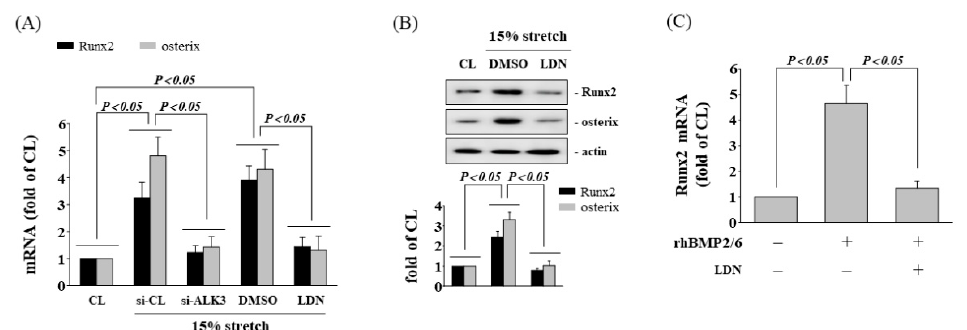
Figure 7. Inhibition of ALK3 receptor decreases HCS-induced osteogenic gene expression. AF cells were maintained in static conditions as CL or subjected to 15% HCS for 8 h. Before being kept as CL or subjected to CS, AF cells were transfected with control siRNA (si-CL), or a specific siRNA of si-SMAD, or were pretreated with DMSO, or specific kinase inhibitors for ALK3 (LDN) for 1 h, and then subjected to 15% HCS for 8 h. The gene ( A ) and protein ( B ) expression of Runx2 were examined by real-time PCR and Western blotting, respectively. The results are shown as mean ± SD. ( C ) AF cells were kept as CL or stimulated with rhBMP-2/6. Before being kept as CL or stimulated with rhBMP-2/6, AF cells were pretreated with DMSO, or specific kinase inhibitors for ALK3 (LDN) for 1 h, and then stimulated with rhBMP-2/6 for 8 h. The mRNA expression of Runx2 was measured by real-time PCR. The results are mean ± SD and are representative of three independent experiments (n = 3). Data statistics were completed with ANOVA followed by Scheffe’s test. The results were considered significant for p < 0.05.